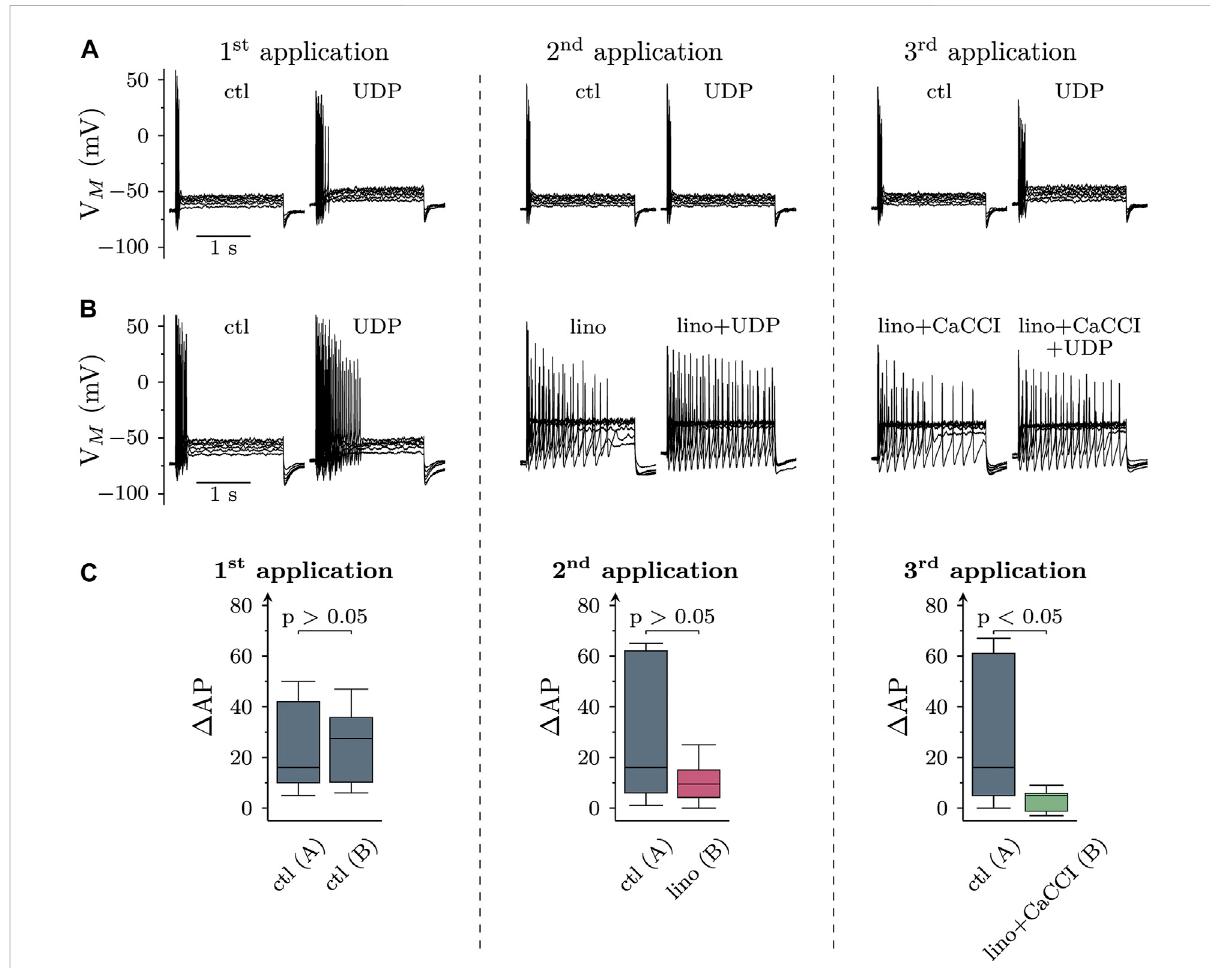
Roles of K V 7 channel inhibition and CaCC activation in the effects of UDP on sympathetic neuron excitability. Membrane potential was measured in perforated-patch current clamp in single SCG neurons, and 6 depolarizing 2 s currents with amplitudes of 50, 100, 150, 200, 250, and 300 pA were injected to trigger action potentials. Three consecutive applications of UDP (10 µM for 120 s) were separated by two 5 min periods (represented by vertical dashed lines). (A) and (B) show original traces obtained before and during the presence of UDP, (C) summarizes the changes in AP fi ring ( Δ AP) due to the presence of UDP with data at each left hand side derived from A and those at each right hand side derived from (B) . (A) Original current clamp traces were obtained with three consecutive applications of UDP (10 µM for 120 s) in solvent (DMSO) interleaved by 5 min periods of solvent (DMSO) only. The traces have been obtained just before and at the end of the three 120 s UDP applications. (B) Original traces were obtained with three consecutive applications of UDP (10 µM for 120 s), fi rst in solvent (DMSO), and then in DMSO plus linopirdine (lino; 30 µM), and thereafter in DMSO plus linopirdine plus CaCCInh-A01 (10 μ M; lino + CaCCI). These drugs or drug combinations were also present for 120 s prior to current injection. The traces have been obtained just before and at the end of the three 120 s UDP applications. Linopirdine on its own caused depolarizations that were compensated for by hyperpolarizing current injections. (C) Box plots showing changes in AP fi ring ( Δ AP) in responsetothethreeconsecutiveUDPapplications(1st,2nd,3rd)eitherinsolventonly[ctl; n =11;asin (A) orinsolventfollowedbylinopirdine(lino) andlinopirdineplusCaCCI(lino+CaCCI; n =12;asin (B) ].The p valuesabovethethreepairsofboxesindicatedifferencesbetweensolventonly(left hand boxes) and the drug treated groups (right hand boxes; Mann-Whitney U